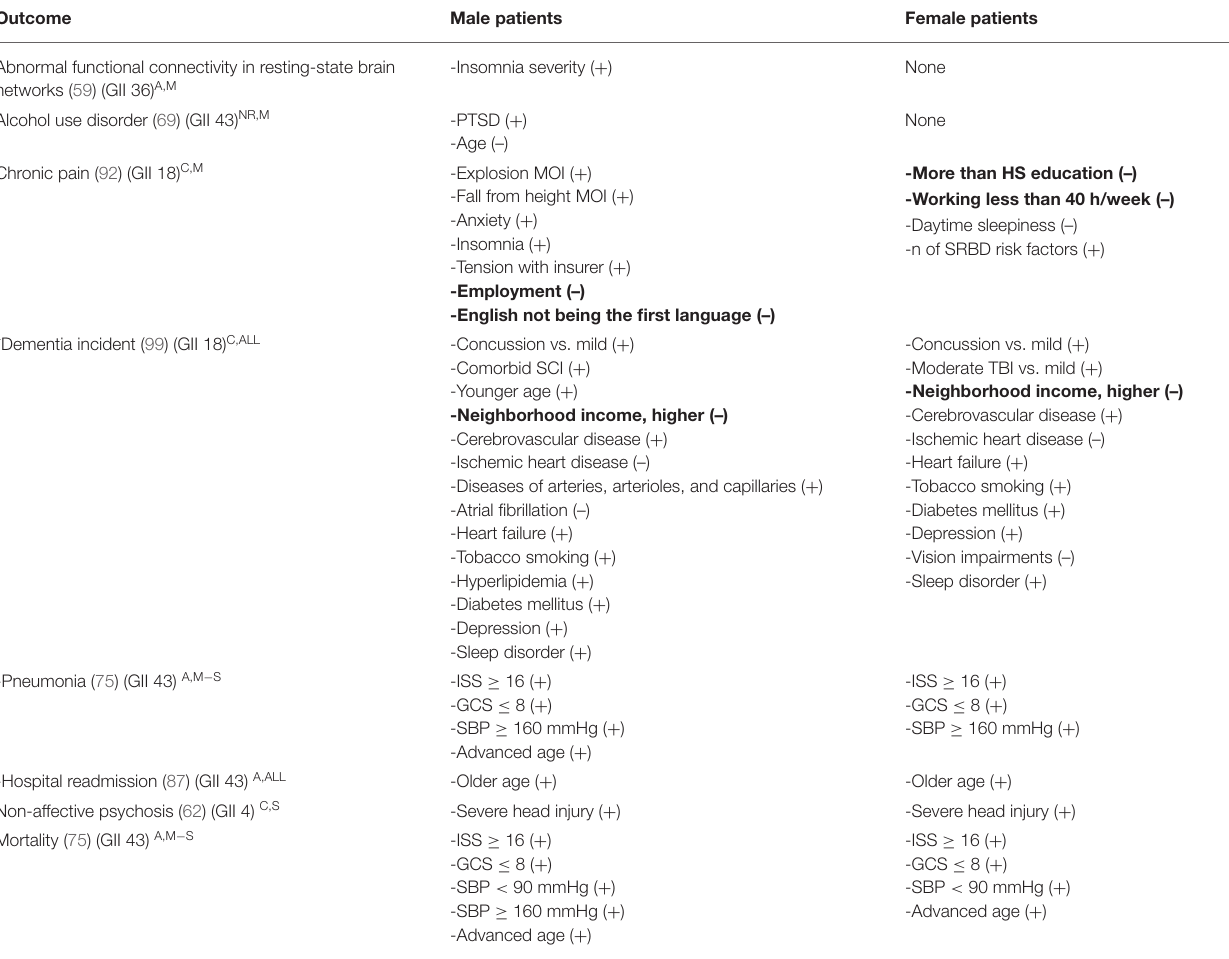
TABLE 3 | Results from studies analyzing the relationship between outcome and variables on male and female persons separately. Outcome Male patients Abnormal functional connectivity in resting-state brain networks (59) (GII 36)